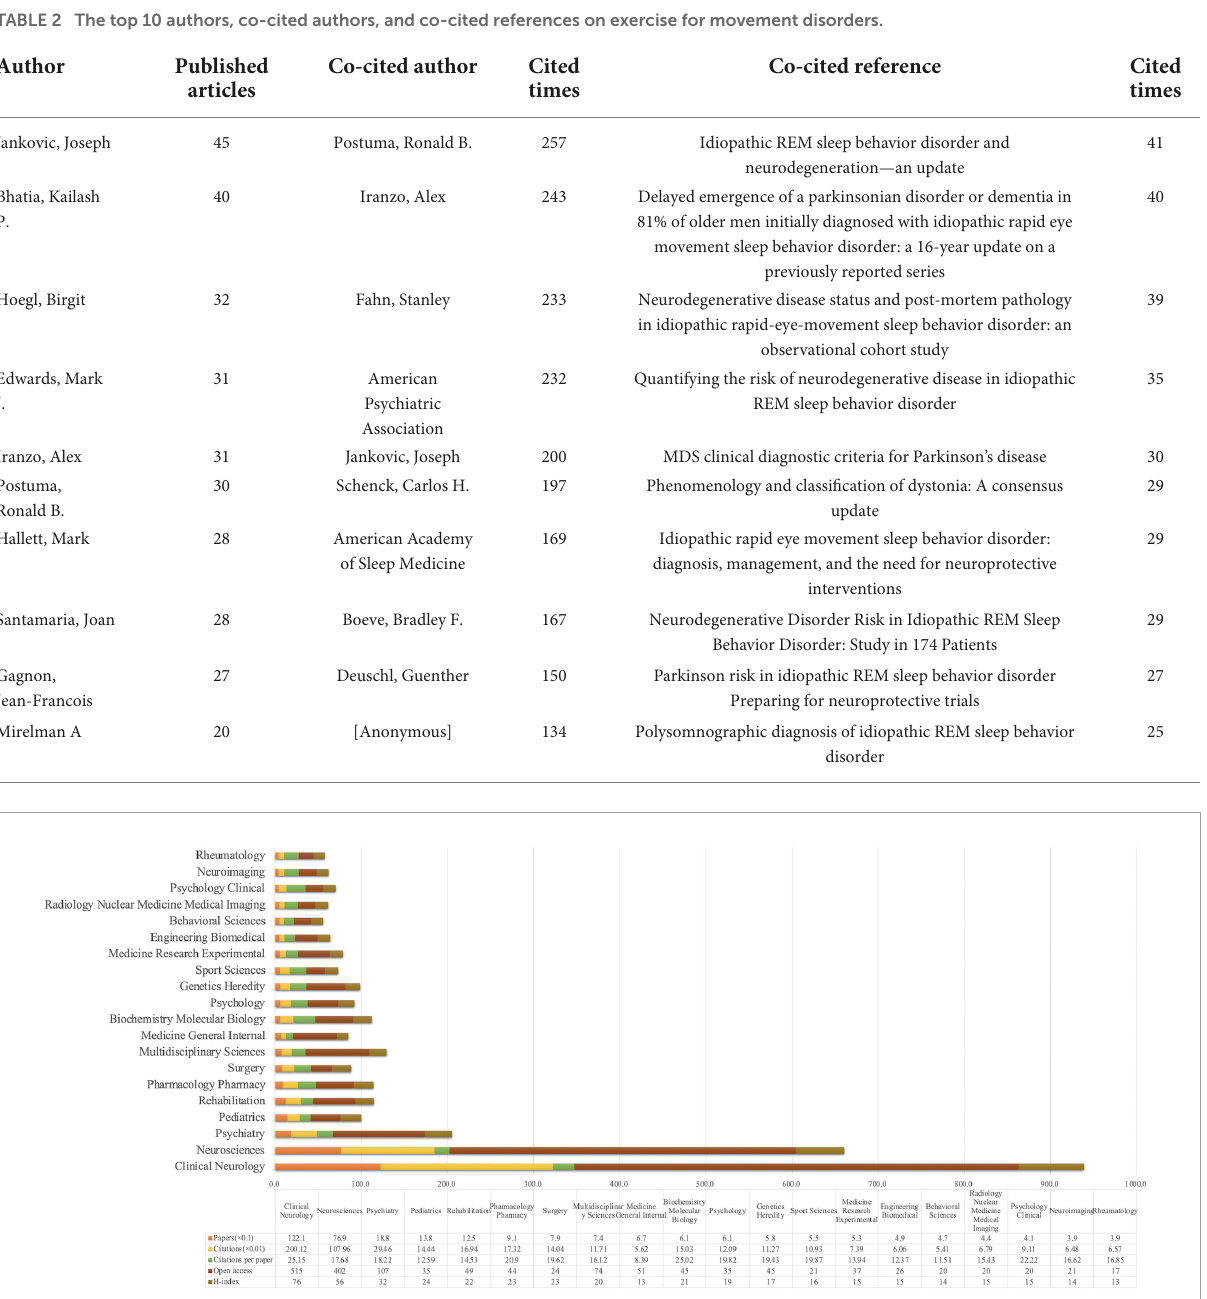
by keywords of co-cited references. Dystonia, narcolepsy, and gnao1 were labeled as the first cluster #0, second cluster #1, and third cluster #2, respectively. In the analysis of co-cited literature ( Table 2 ), “Idiopathic REM sleep behavior disorder and neurodegeneration-an update (Högl et al., 2018)” had the highest number of co-citations (41), meanwhile, “The spectrum of movement disorders in children with anti-NMDA